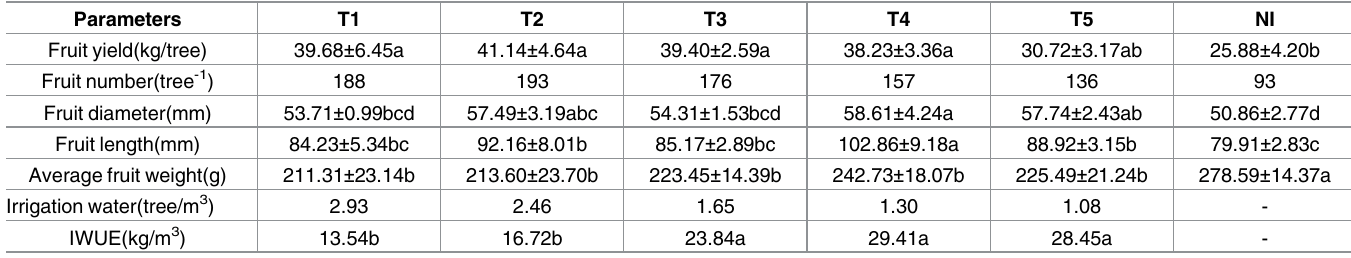
Table 3. Some parameters of yield and irrigation under different irrigation